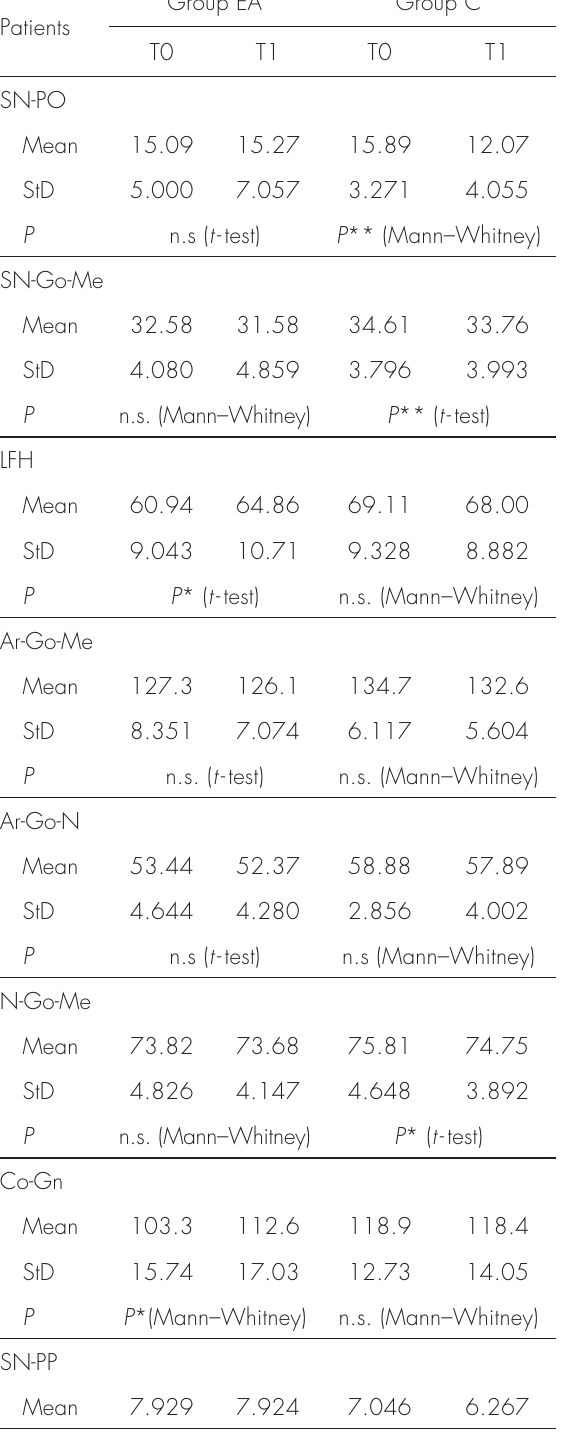
Table I. Skeletal differences. Table II. Dental and aesthetic differences.